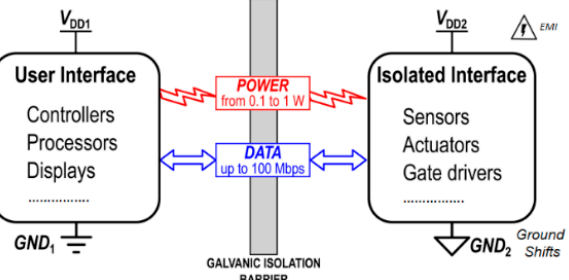
Figure 1. Simplified block-diagram of a galvanically isolated system. Reproduced from [1]. Copyright 2019, Springer Nature Customer Service Centre GmbH.